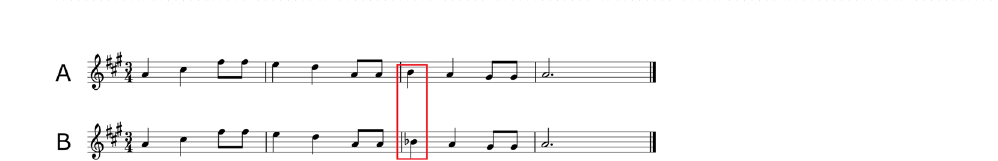
Table 1. Participant demographics.